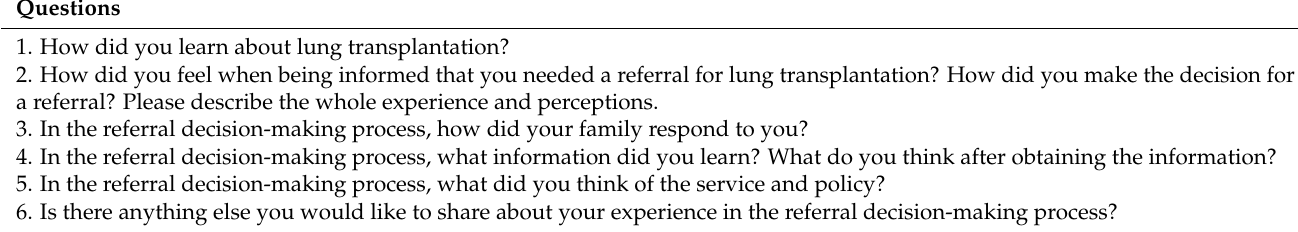
Table 1. Interview